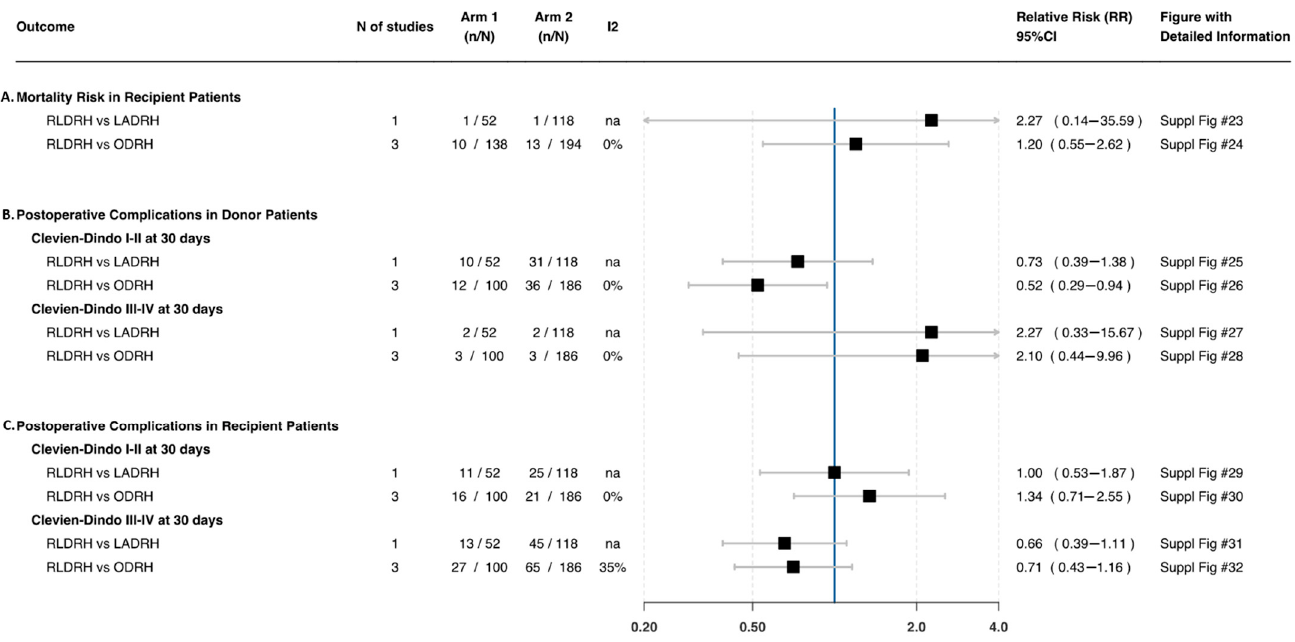
Figure 2. Risk ratio of postoperative Clavien–Dindo complications and mortality in recipients and donors. Suppl figs can be found in Github, please refer to Section 2.8. donors. Suppl figs can be found in Github, please refer to Section